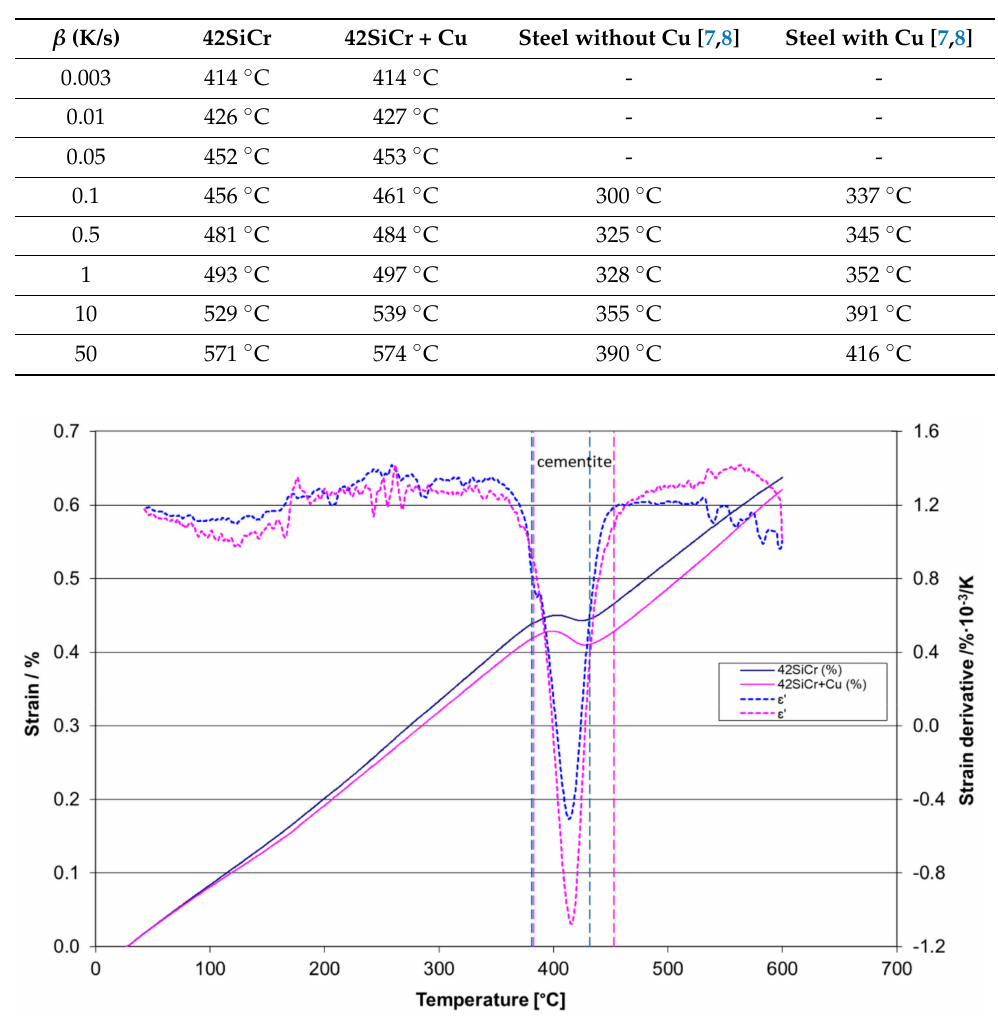
Table 3. Temperatures corresponding to inflection points ( T i ) at different heating rates ( β ) for stage II of tempering in the dilatometry data.